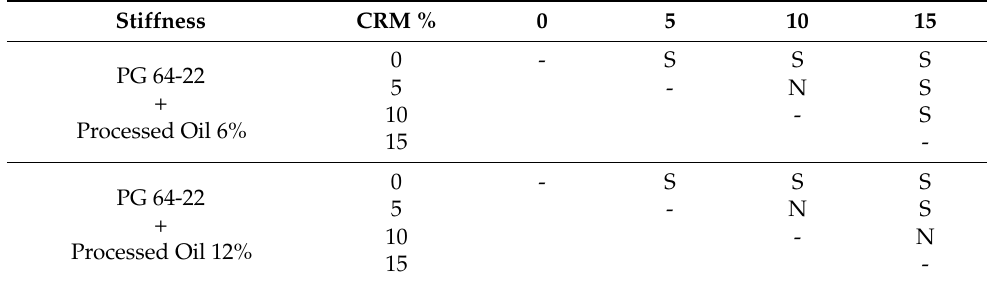
Table 9. Statistical analysis of stiffness for RTFO + PAV aged PG 64-22 binder modified with 6% and